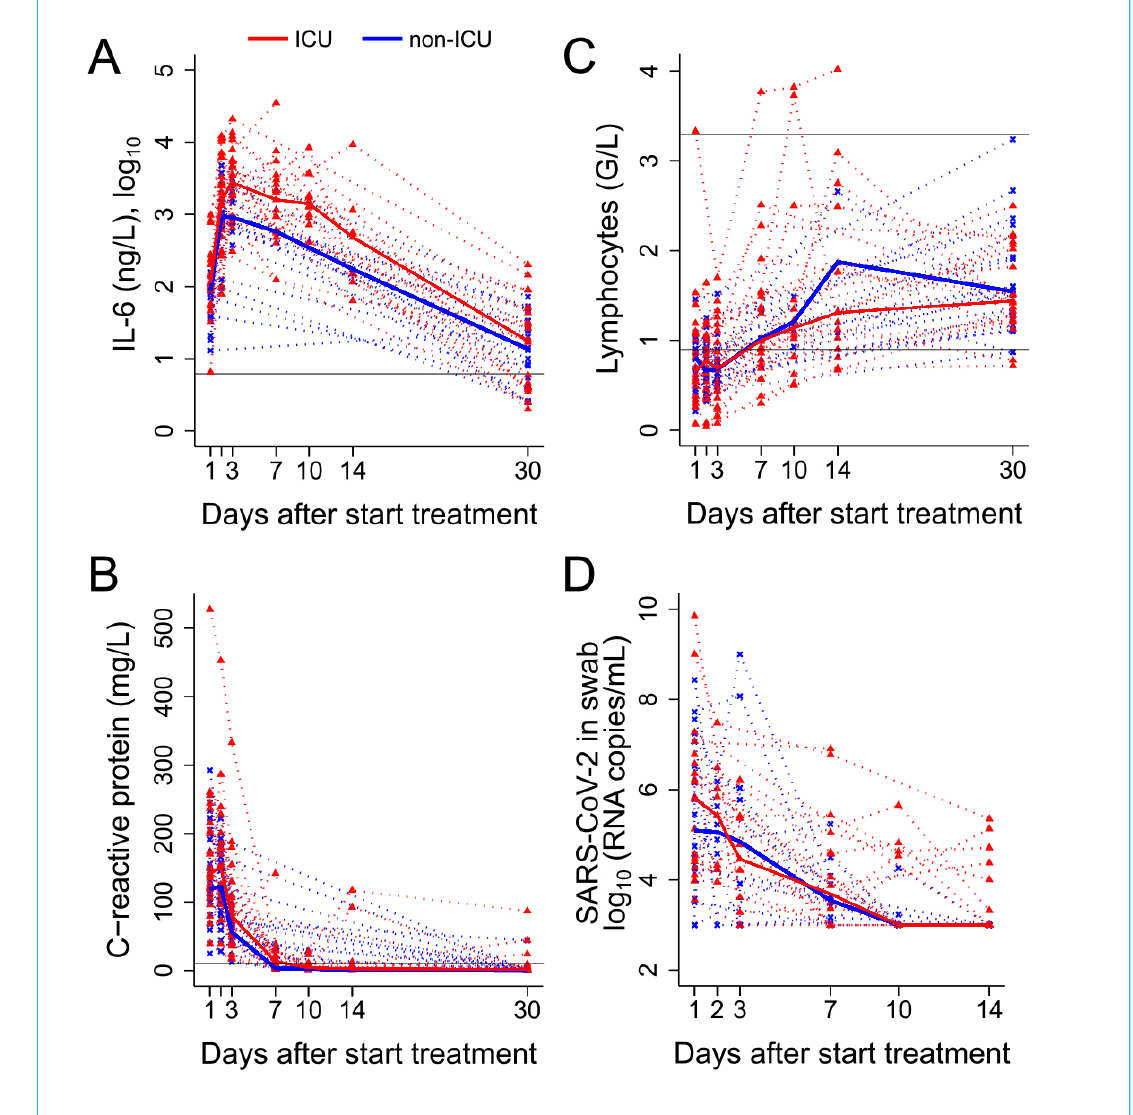
Figure 2: The course of laboratory markers over time from treatment initiation in intensive care unit (ICU) and non-ICU patients.The course of (A) interleukin (IL)-6, (B) C-reactive protein, (C) absolute lymphocyte counts, (D) severe acute respiratory syndrome coronavirus-2 (SARS- CoV-2) load in nasopharyngeal swabs. Dotted lines represent the individual courses of inflammatory markers and absolute lymphocytes over 30 days and SARS-CoV-2 loads in nasopharyngeal swabs over 14 days from treatment initiation in ICU (red line, n = 26) vs non-ICU (blue line, n = 24) patients. Black solid lines represent the reference